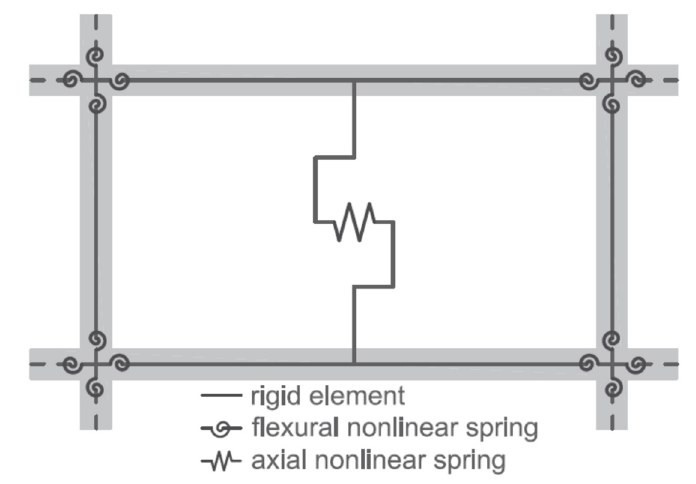
Figure 3. Schematic of the structural model.